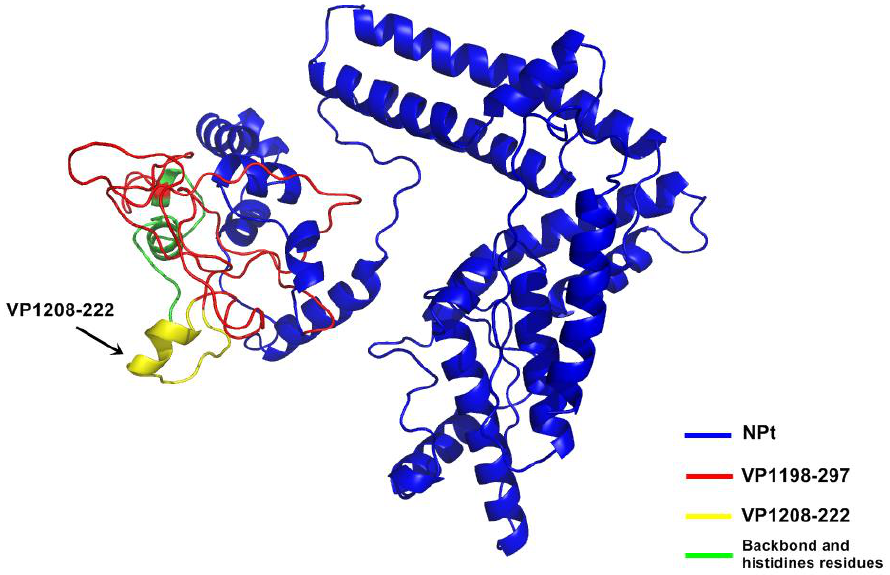
Figure 2. Predicted three-dimensional (3D) structure of recombinant NPt-VP1198–297 protein.